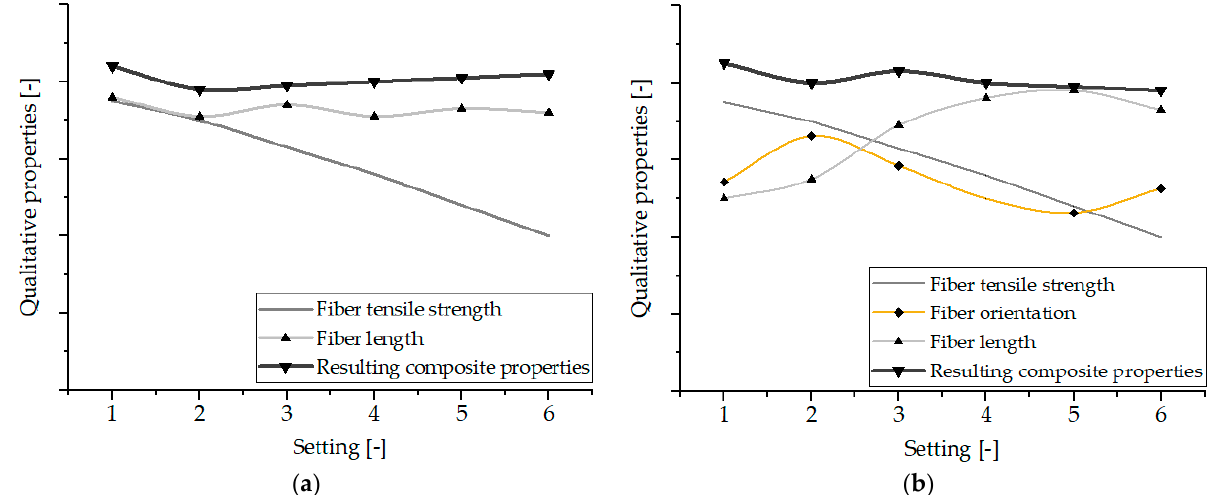
Figure 11. Qualitative curves of structural properties (fiber tensile strength, fiber length, and fiber orientation) and resulting composite properties of the characterized setting for the valve gate ( a ) and the open hot runner system ( b ).